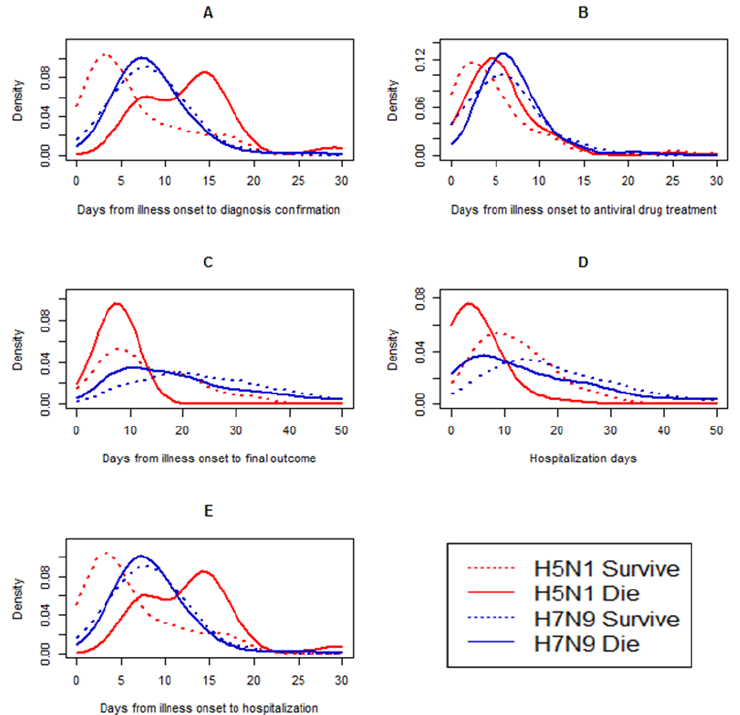
Figure 4. Comparisons of time-delay distributions for laboratory-confirmed human avian influenza A H7N9 and H5N1 virus fatalities and survivors. The number of H5N1 fatalities = 280; the number of H5N1 survivors = 151; the number of H7N9 fatalities = 265; and the of H7N9 survivors = 391. ( A ) Days from illness onset to laboratory confirmation of influenza A H7N9 or H5N1 virus fatalities and survivors. ( B ) Days from illness onset to antiviral treatment of influenza A H7N9 or H5N1 virus fatalities and survivors. ( C ) Days from illness onset to final outcome of infection (fatality or survival) with influenza A H7N9 or H5N1 viruses. ( D ) Days of hospitalization for A H7N9 or H5N1 fatalities and survivors. ( E ) Days from illness onset to hospitalization for A H7N9 or H5N1 fatalities and survivors.